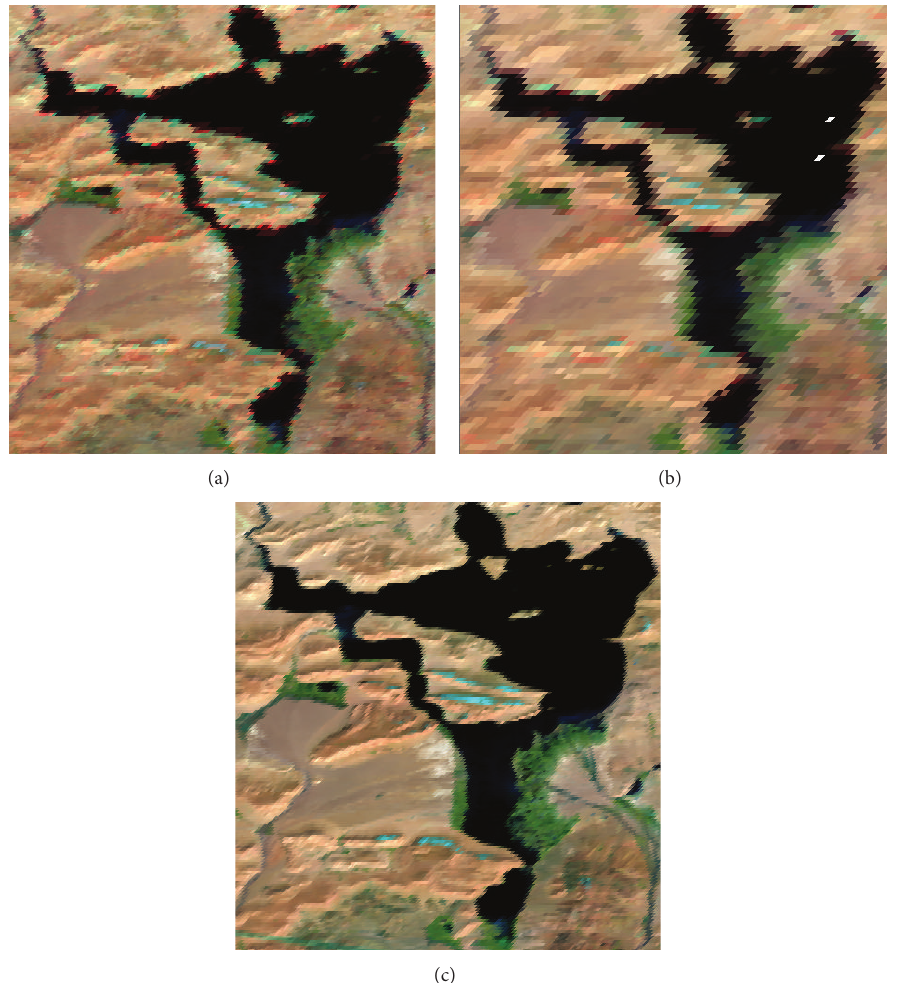
Figure 4: False color composite images (621) over Co Ngoin; October 7, 2000. (a) Shows downscaled data at 250 m spatial resolution; (b) shows original data at 500 m; (c) shows Landsat-7 ETM+ image aggregated to 250 m from 30m spatial resolution.